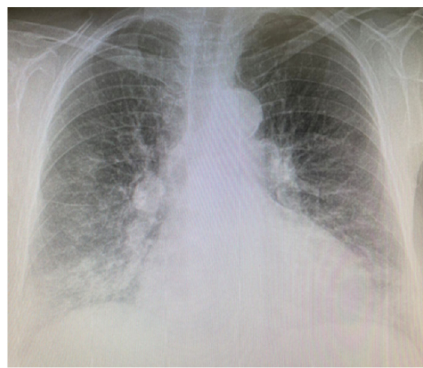
Figure 6. Chest X-Ray—2017—Case 3. Nodular and micronodular opacities localized mainly in the lower lobes. Veiling of the pulmonary bases. Reticular opacities on both pulmonary areas. Enlarged cardiac silhouette.